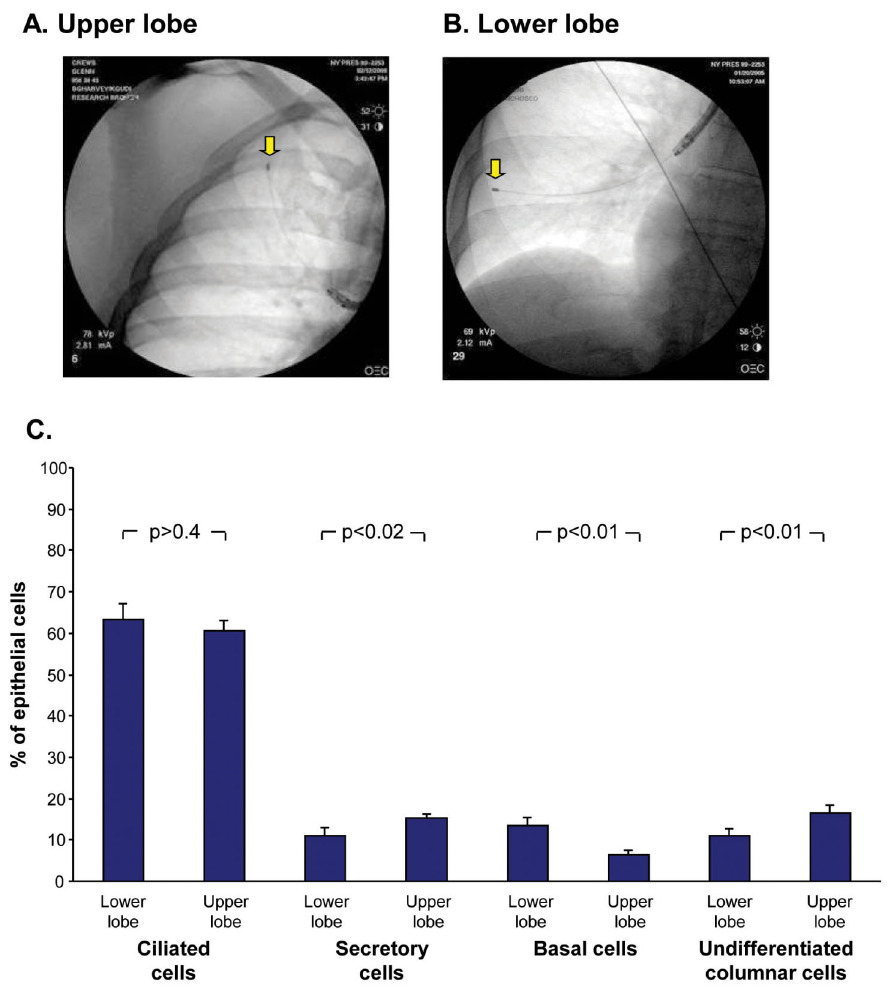
Figure 1. Sampling of small airway epithelium of upper vs lower lobes. A, B. Fluoroscopy of the upper and lower lobes showing the position of the brush used for sampling (arrows). C. Epithelial cell types in the upper vs lower lobes. Shown is data (mean 6 standard error) based on counting 500 cells in cytocentrifuge preparations of upper vs lower lobe small airway epithelial samples. p values for paired t-test between upper and lower lobes are